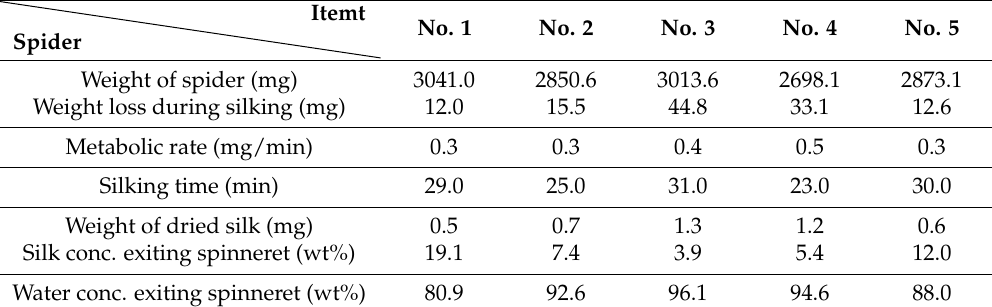
Table 1. Summary of liquid and solid content estimation on major ampullate dragline silk immediately drawn from the spigots of female N. pilipes